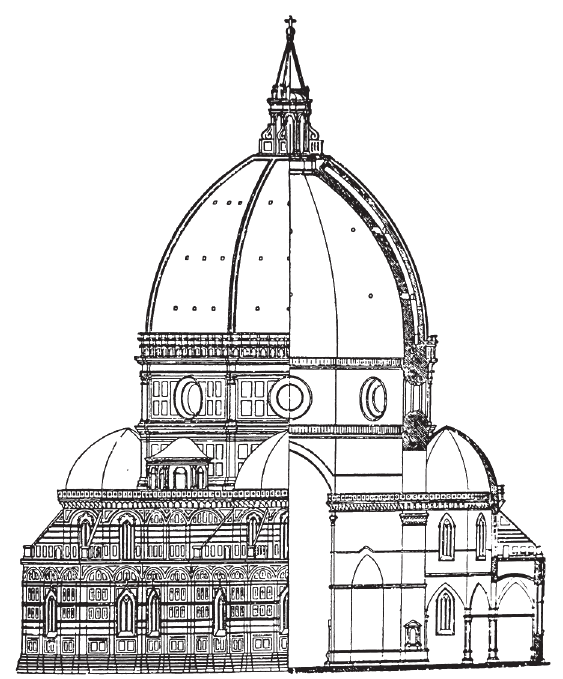
fig. 1. Competition for the dome of Santa Maria del